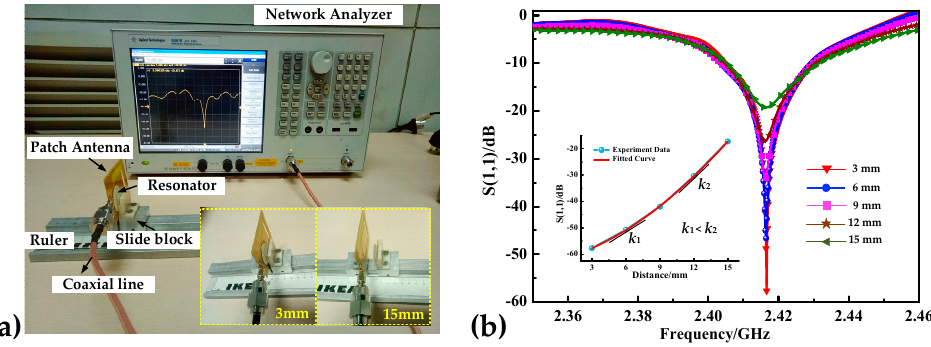
Figure 6. ( a ) Sensing distance testing platform. ( b ) Distance testing curves. The insert map indicates